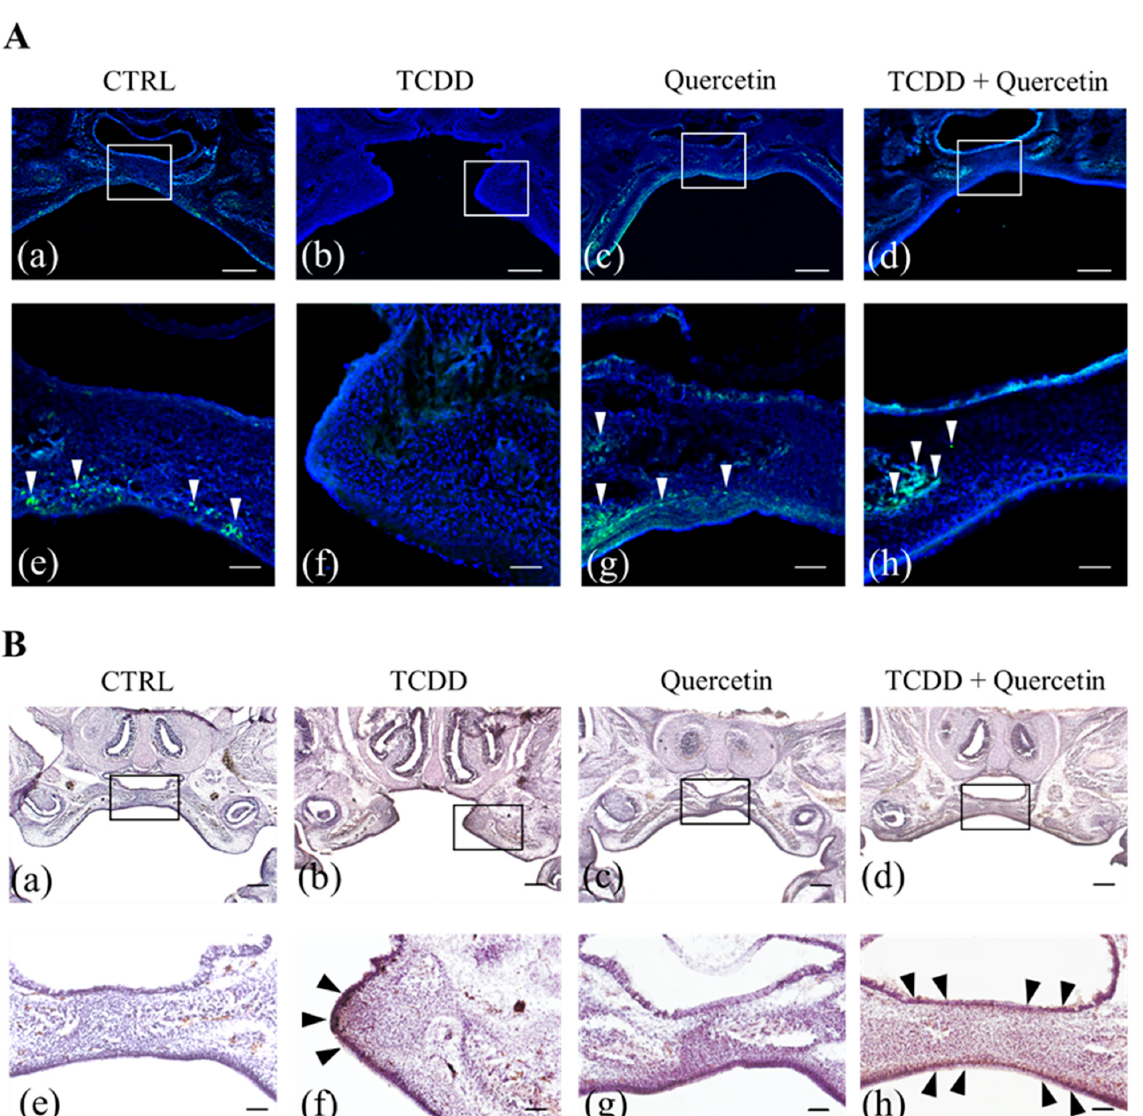
Figure 4. ( A ) Confirmation of cell proliferation in the palate of fetal mice by EdU staining. (a–d) are low magnification (scale bar = 200 μ m). (e–h) are high magnification (scale bar = 50 μ m). Nuclear (Blue: Hoechst 33342), EdU positive cells (Green: Alexa Fluor 488). White arrows indicate EdU positive cells. In the CTRL and Quercetin groups, EdU positive cells accumulate on the nasal and on the oral surfaces of the palatal process (a,c,e,g). In the TCDD group, EdU positive cells are not found in the palatal process at all, indicating that cell proliferation is suppressed by TCDD (b,f). In the TCDD + Quercetin group, EdU positive cells tend to accumulate in the center of the palatal process. It is also shown that the inhibition of cell proliferation by TCDD is rescued by quercetin (d,h). ( B ) Confirmation of CYP1A1 accumulation in the palate of fetal mice by immunohistochemistry stain- ing. (a–d) are low magnification (scale bar = 100 μ m). (e–h) are high magnification (scale bar = 75 μ m). Black arrows indicate CYP1A1 positive cells. No CYP1A1 positive cells are observed in the CTRL and the Quercetin groups (a,c,e,g). In the TCDD group, CYP1A1 is accumulated at the tip of the palatal process (b,f, black arrow). In the TCDD + Quercetin group, the palatal processes are fused, but there is a diffuse scattering of CYP1A1 positive cells on the palate (d,h, black arrows).